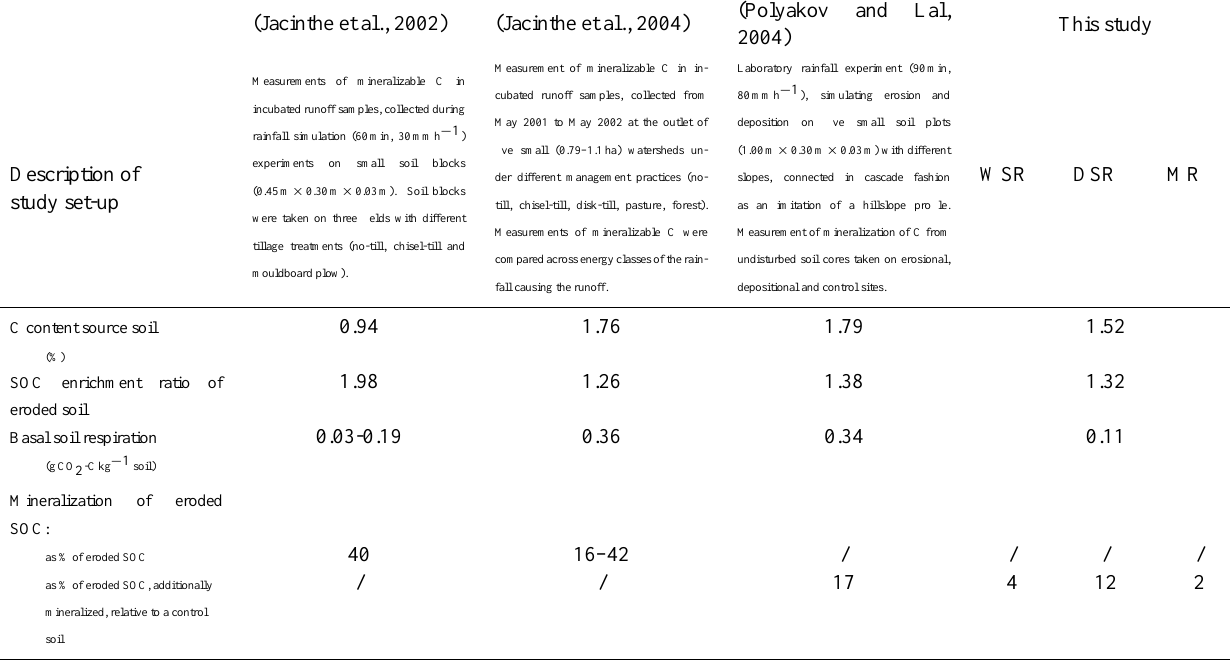
Table 4. Comparison of this study with three other experimental studies, addressing the impact of erosion and deposition processes on SOC decomposition. Results have been recalculated in function of the reported measurements and dimensions